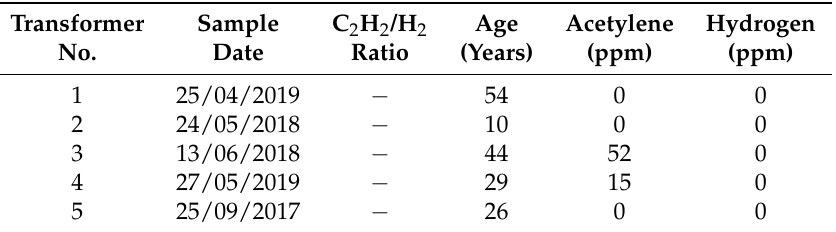
Table 4. Transformer data without the C 2 H 2 /H 2 ratio result.